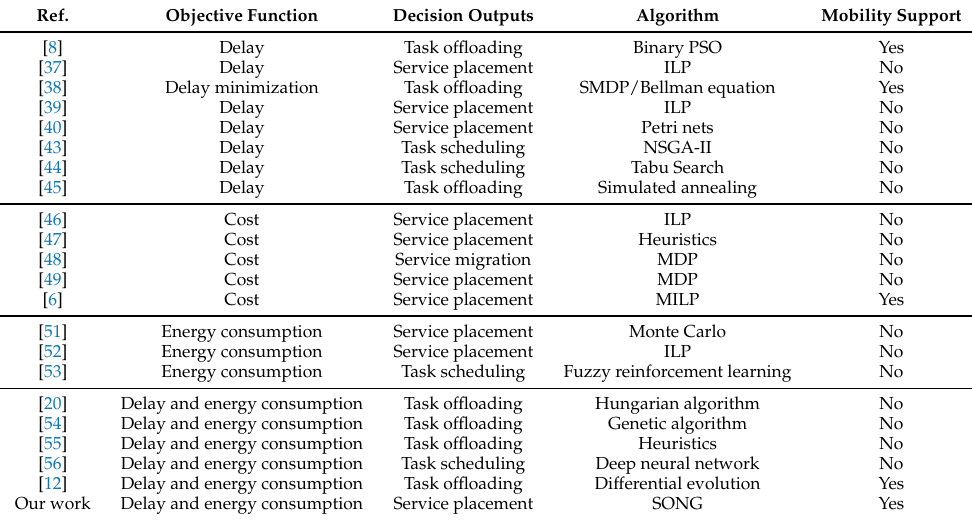
Table 1. Summary of the literature in facility location or service placement problem in VFC or fog